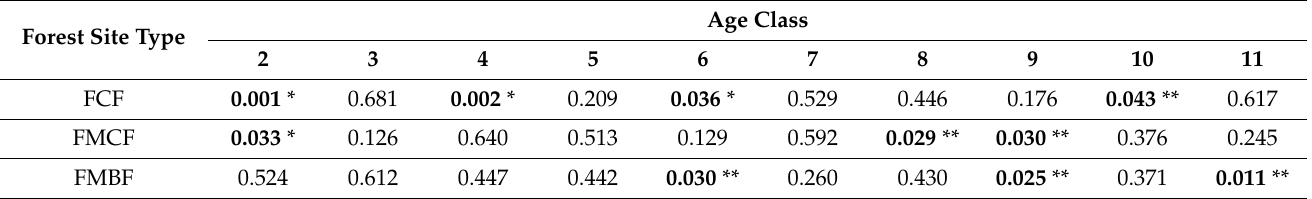
Table 2. Mixed linear model results of differences in the growing stock volume between the edge and the interior (differences were considered significant at p ≤